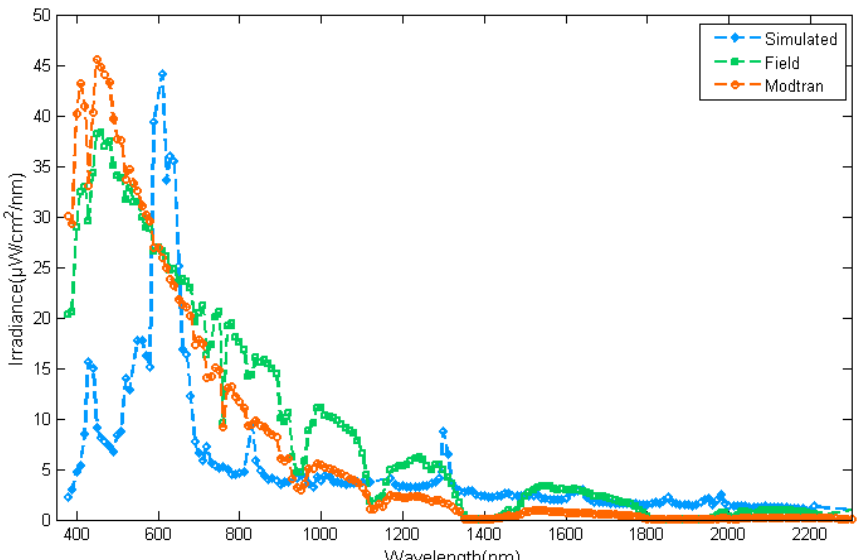
Figure 11. The irradiance of field-collected and simulated skylight (four peaks in the irradiance of the simulator have been removed as bad bands).